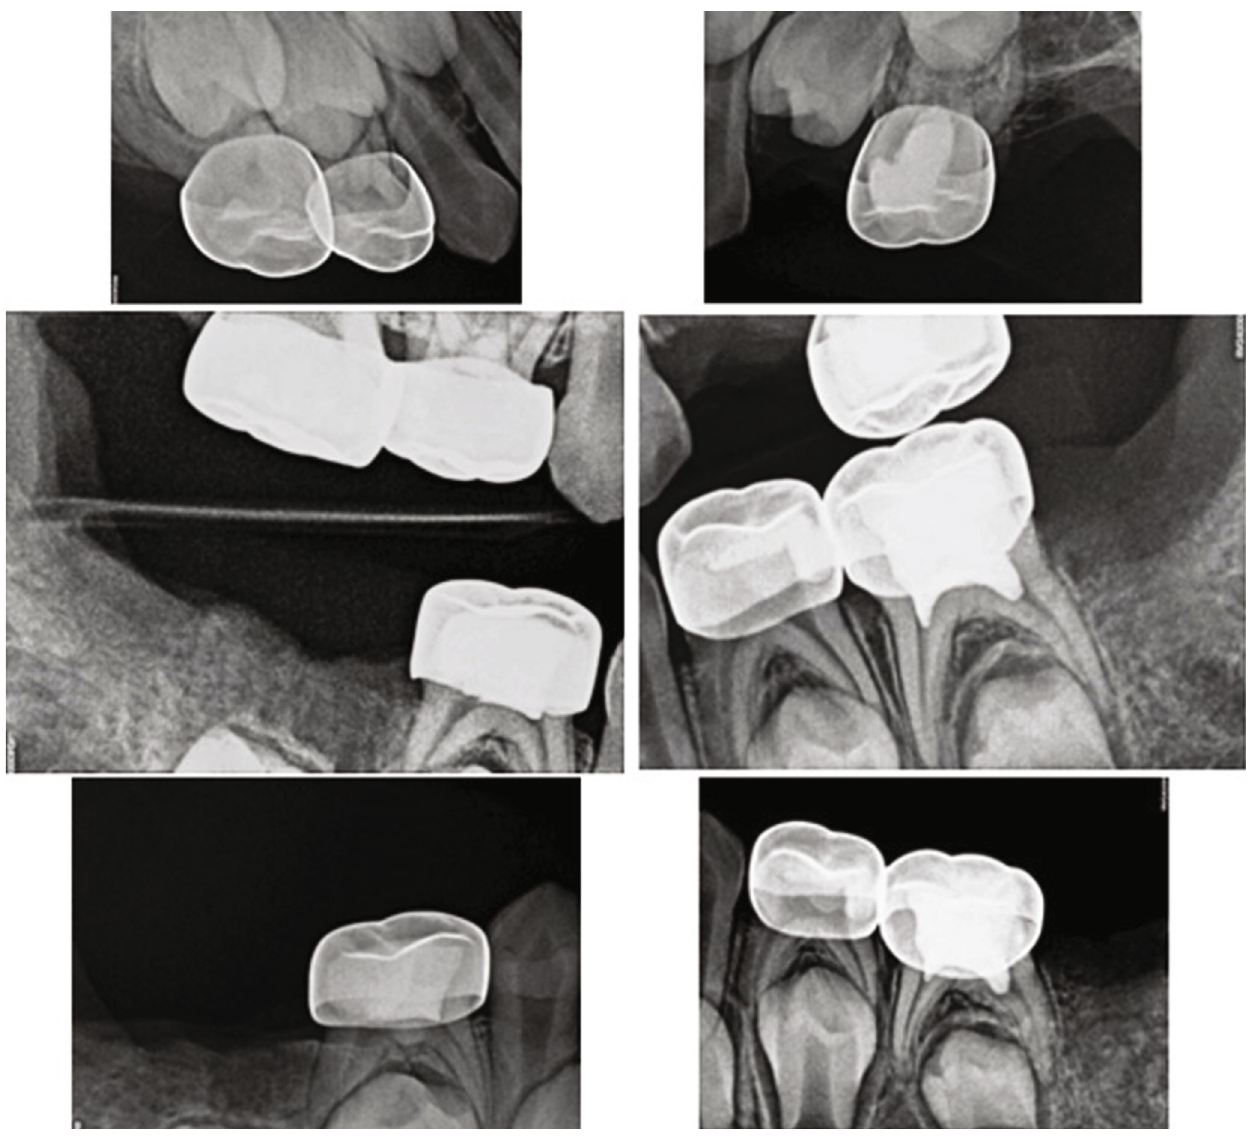
Figure 4: Postoperative